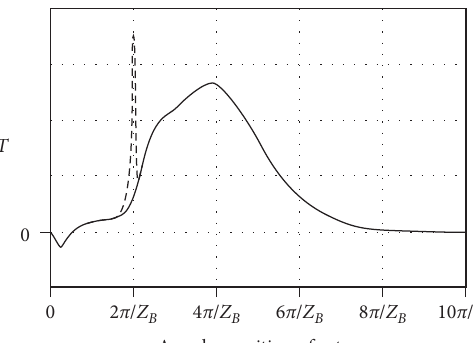
Figure 8: Torque as a function of angular position due to one bucket from CFD calculation and experiments (schematically from [11, 14]).